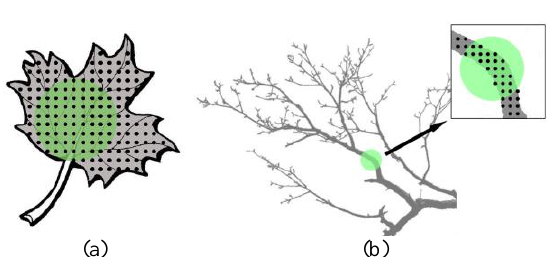
Figure 2. Sketch map of the amount of leaf points (a) and branch points (b) within the same neighbourhood space (the green area)